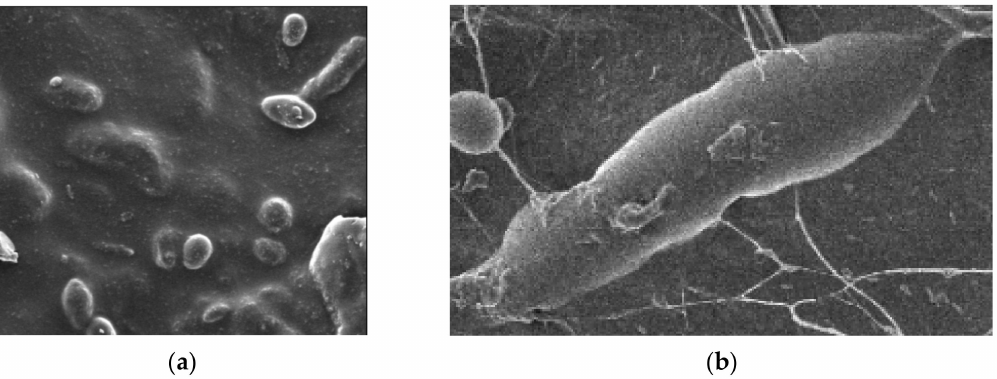
Figure 5. SEM images of BNC samples produced in BNT medium: ( a ) BNC shelters the bacteria and yeast cells on the pellicle; ( b ) extrusion of nanocellulose protofibrils produced by growing bacteria (Figure 5a, 1k magnification; Figure 5b, 5k magnification).